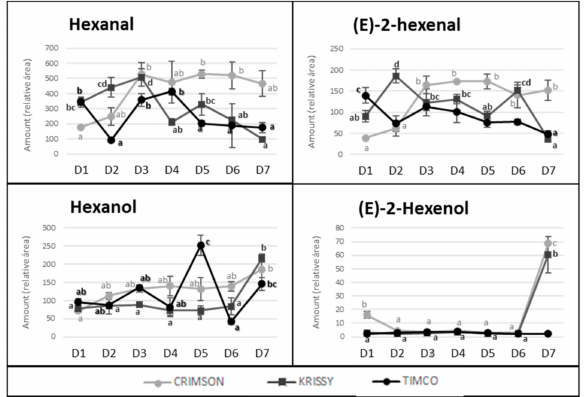
Figure 7. Evolution of hexanal, hexanol, ( E )-2-hexenal, and ( E )-2-hexenol amounts along maturity and storage of Crimson, Krissy, and Timco varieties. Di ff erent superscript letter indicates statistically significant di ff erences among the sampling times D1–D7 ( p < 0.05). Sampling along